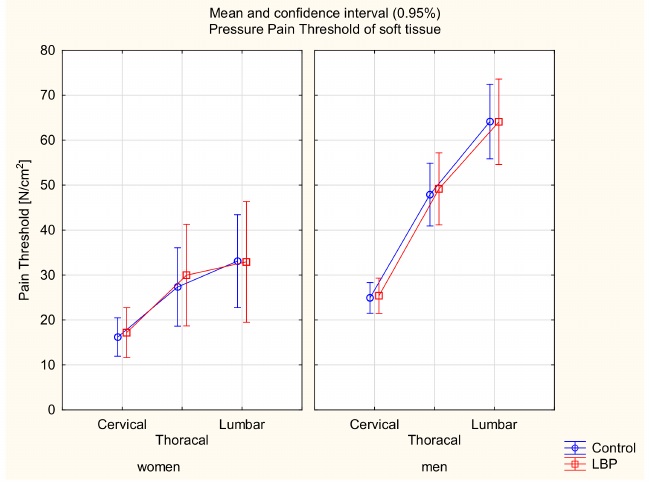
Figure 2. Mean and 95% CI of the pressure pain threshold in women and men groups and in the control and LBP groups.